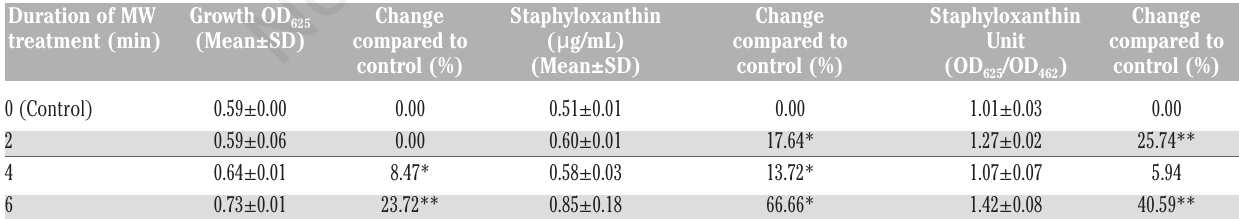
Table 2. Effect of low power microwaves (MW) on growth and staphyloxanth in production in S. aureus. Duration of MW